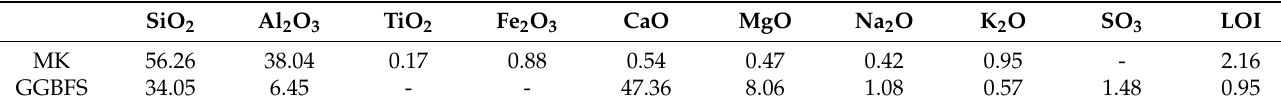
Table 2. Chemical compositions (wt%) of metakaolin (MK) and slag (GGBFS). SiO 2 Al 2 O